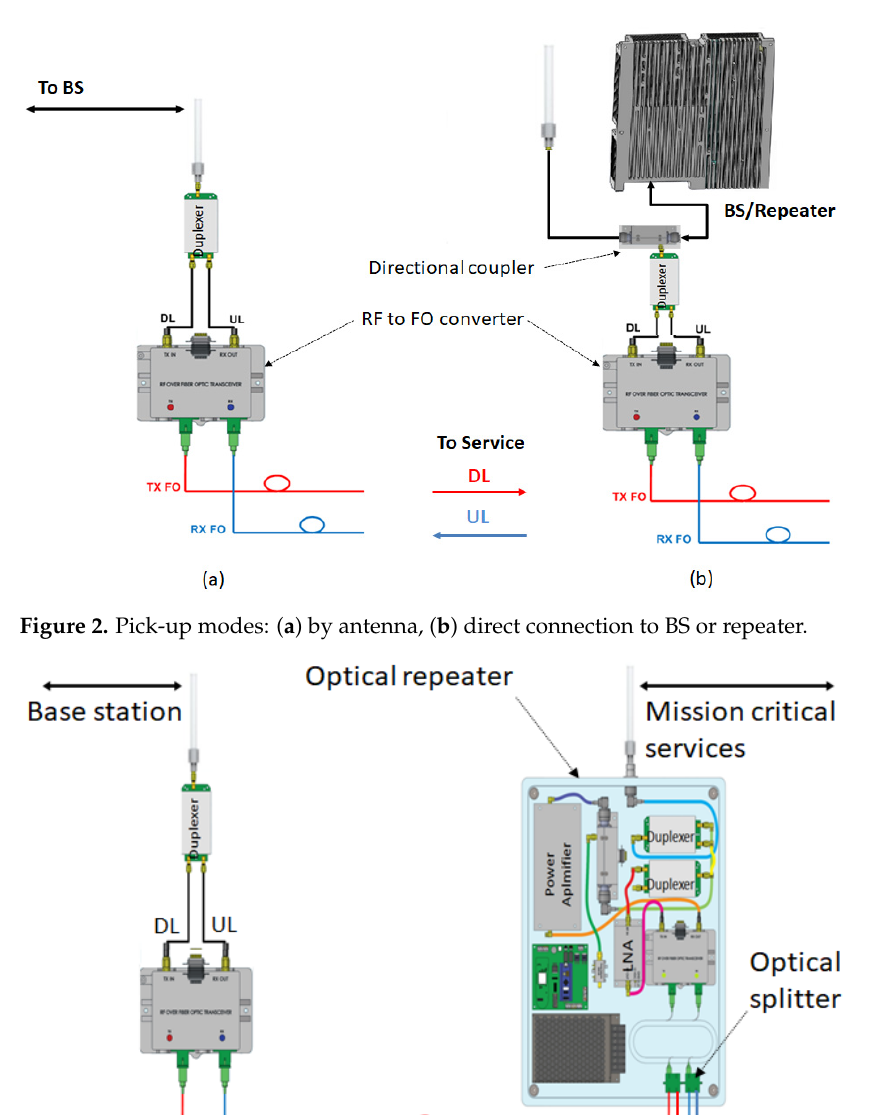
Figure 3. Left—simple pick-up system, right—optical repeater .